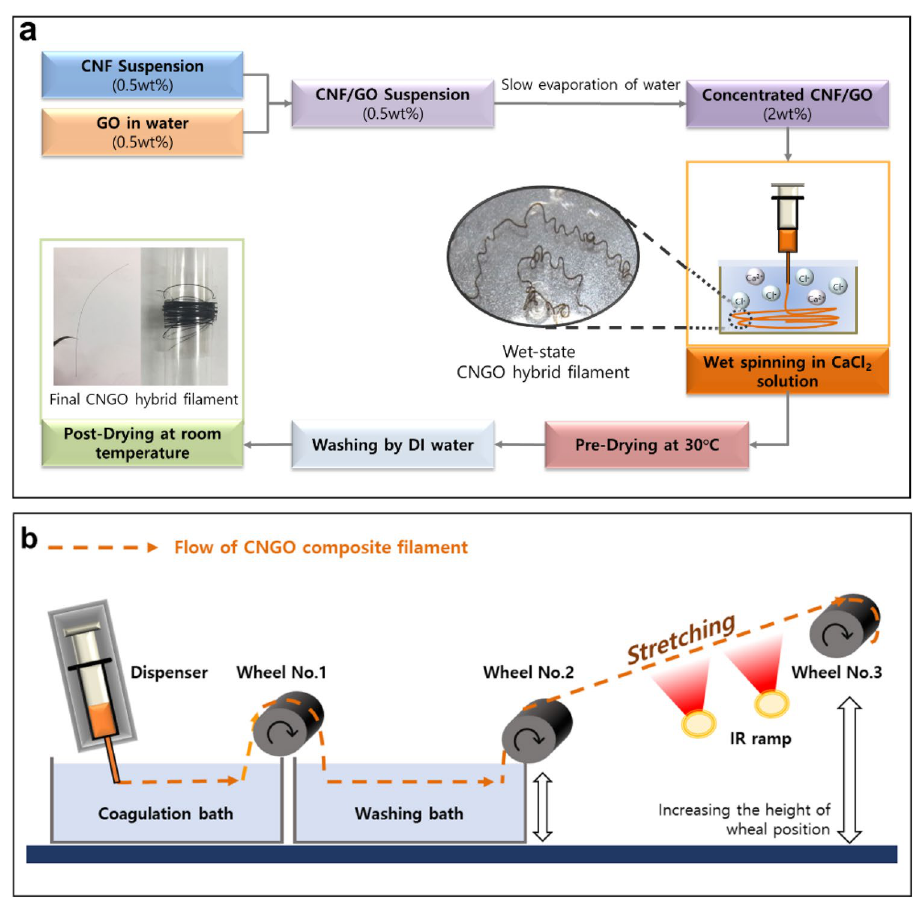
Figure 1. Schematic diagrams of the CNGO hybrid filament preparation: ( a ) the manual process and ( b ) the continuous